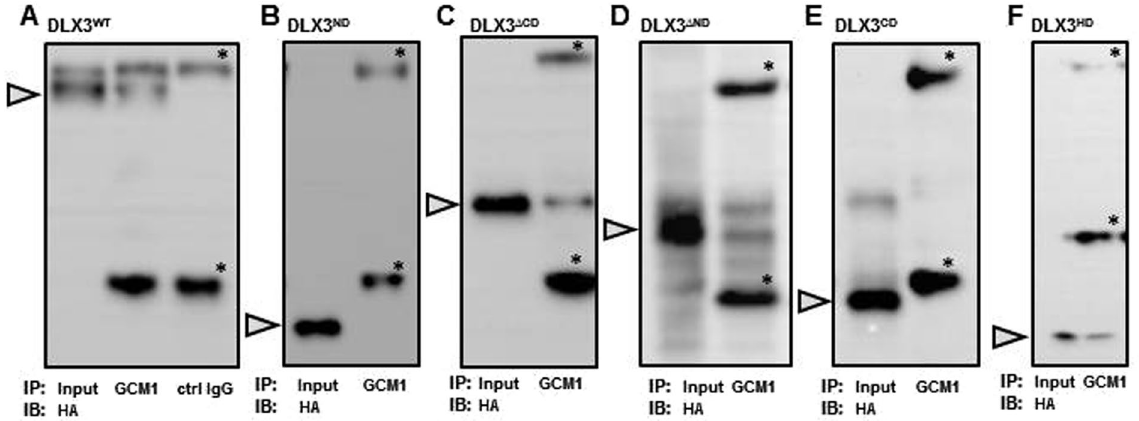
Figure 3. The DLX3 HD is required for a physical interaction between DLX3-GCM1. JEG-3 cells were transfected with indicated DLX3 structural domain expression plasmid for 48 h and treated with 10 μ M MG- 132 for 6 h. Whole cell lysates were collected for immunoprecipitation (IP) of endogenous GCM1 using the anti-GCM1 antibody followed by immunoblotting with the anti-HA antibody to detect the Dlx3 domain. The panels depict: ( A ) Wild type DLX3 (WT) ; ( B ) Amino-terminal domain of DLX3 (ND) ; ( C ) Deletion of the carboxyl- terminal domain of DLX3 ( ∆ CD) ; ( D ) Deletion of the amino-terminal domain of DLX3 ( ∆ ND) ; ( E ) Carboxyl- terminal domain of DLX3 (CD) ; and ( F ) Homeodomain of DLX3 (HD) . The grey arrowhead identifies the relevant input bands for the individual domains. Non-specific goat IgG isotype control antibody was used as the negative control for IPs and is shown only for the DLX3WT ( A ; ctrl IgG) but was used in each individual IP (not shown) and heavy and light chain IgGs are denoted with asterisks in each panel. Input reflects 5% whole cell lysates used in each IP. Independent experiments were performed three times and representative cropped images are shown. Uncropped blots are shown in Supplementary Figure